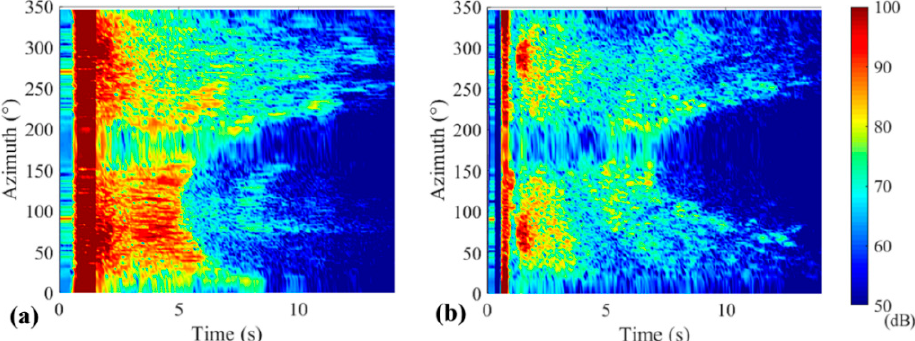
Figure 9. Bearing-time record for ( a ) ping 97 and ( b ) ping 144.